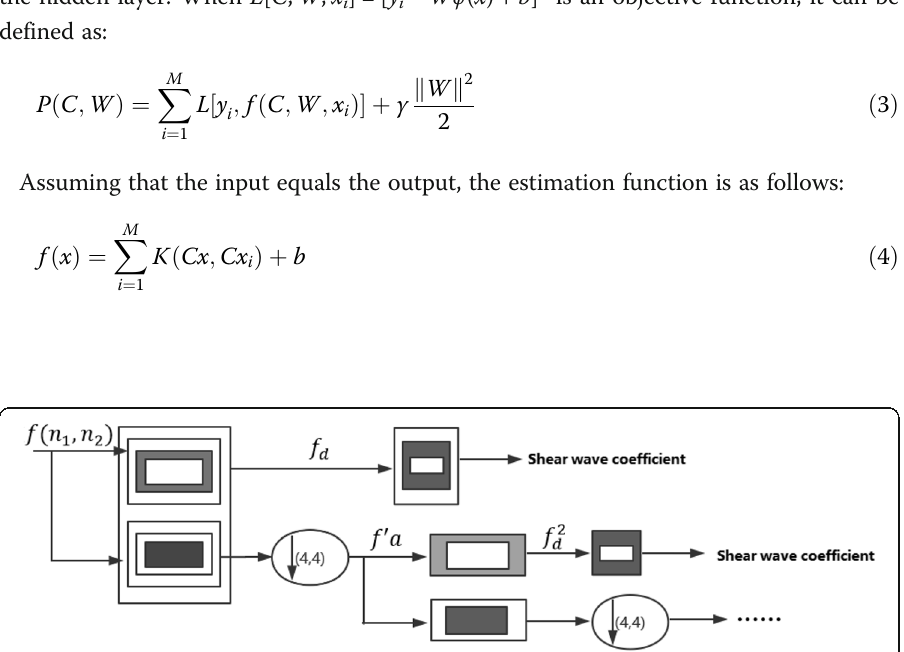
Fig. 2 process of image processing for Space-Ground-Sea Wireless